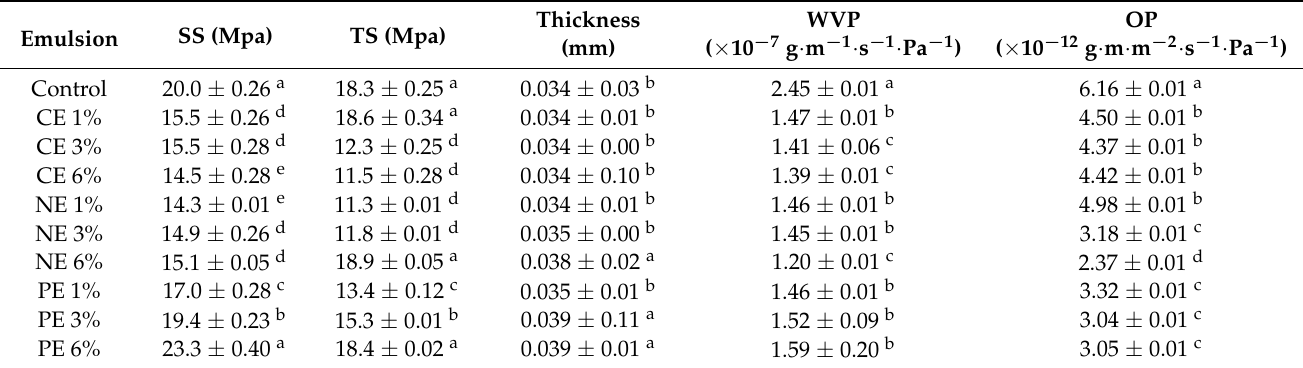
Table 3. Physical and mechanical properties of LDPE film-treated cold plasma-stabilized